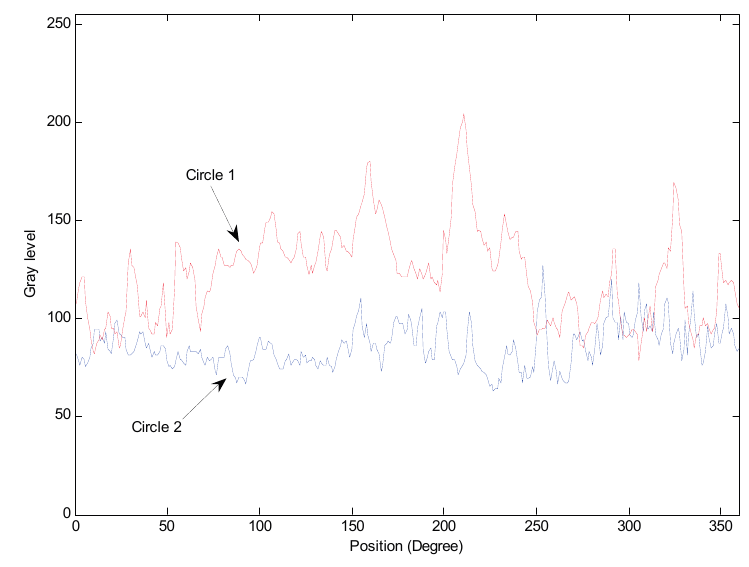
Figure 9. The distribution of gray levels of the circle